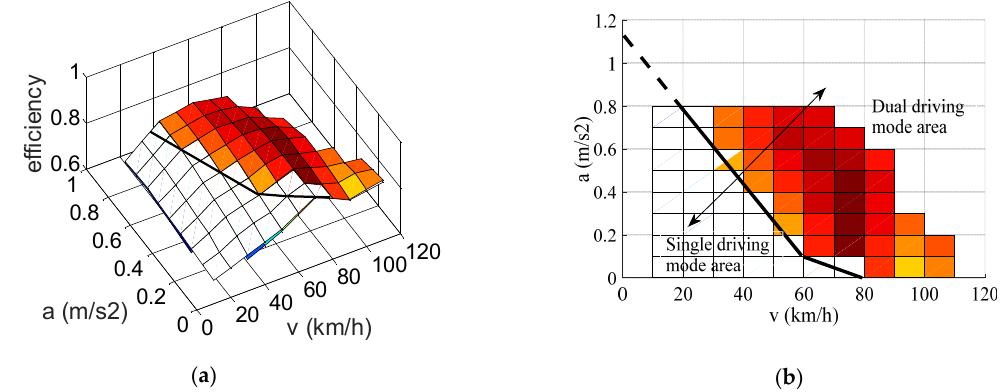
Figure 10. Efficiency comparison and switching rule under Condition 4. ( a ) Efficiency comparison under Condition 4; ( b ) Switching rule under Condition 4.